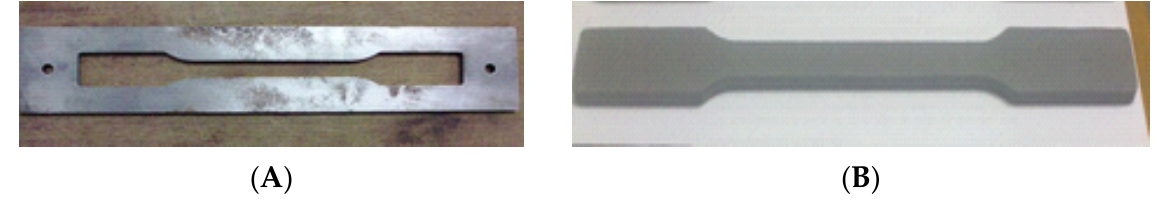
Figure 4. Dumbbell-Shape; ( A ) Aluminium Mould; ( B ) Specimen.